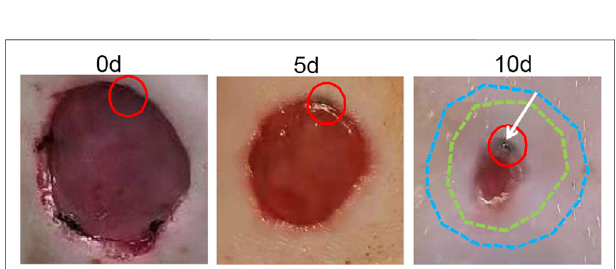
FIGURE 5 | Wound migration process. The position of the suture was markedwitharedcircleaftermodeling;theshapeofthewoundaftermodeling was marked with blue dotted lines; the shape of the wound 5 days after modeling was marked with green dotted lines; the direction of suture migration was indicated by a white